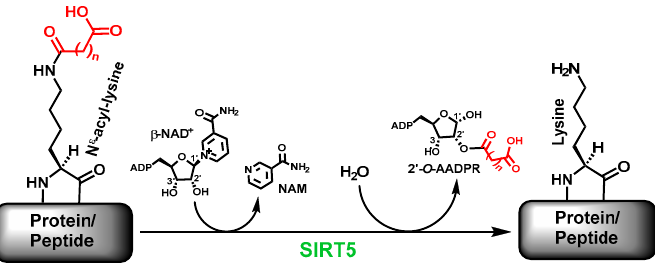
Figure 1. The SIRT5-catalyzed β -NAD + -dependent N ε -acyl-lysine deacylation reactions, including demalonylation ( n = 1), desuccinylation ( n = 2), and deglutarylation ( n = 3). Since these three deacylase activities of SIRT5 are stronger than its deacetylase activity, this latter enzymatic activity is not depicted here. ADP, adenosine diphosphate; β -NAD + , β -nicotinamide adenine dinucleotide; NAM, nicotinamide; and 2’- O- AADPR, 2’- O- acyl-ADP-ribose.